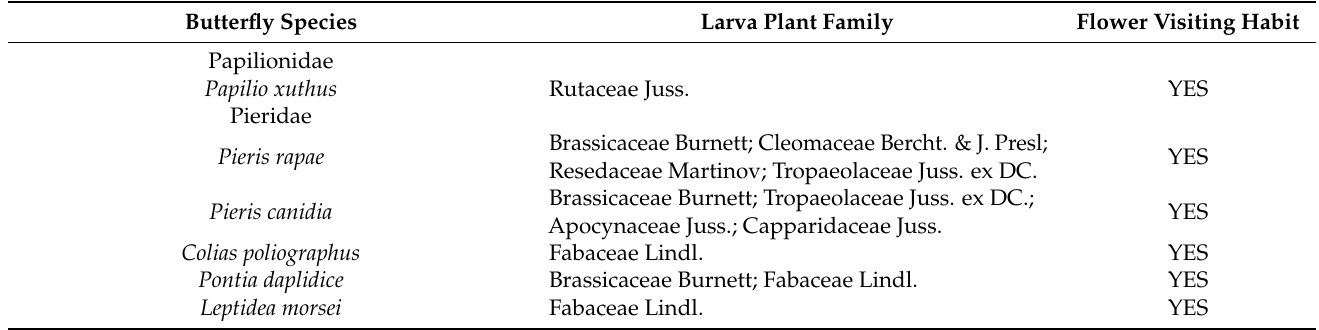
Table A4. The larva plant family and flower visiting habit of butterfly species in Beijing’ urban